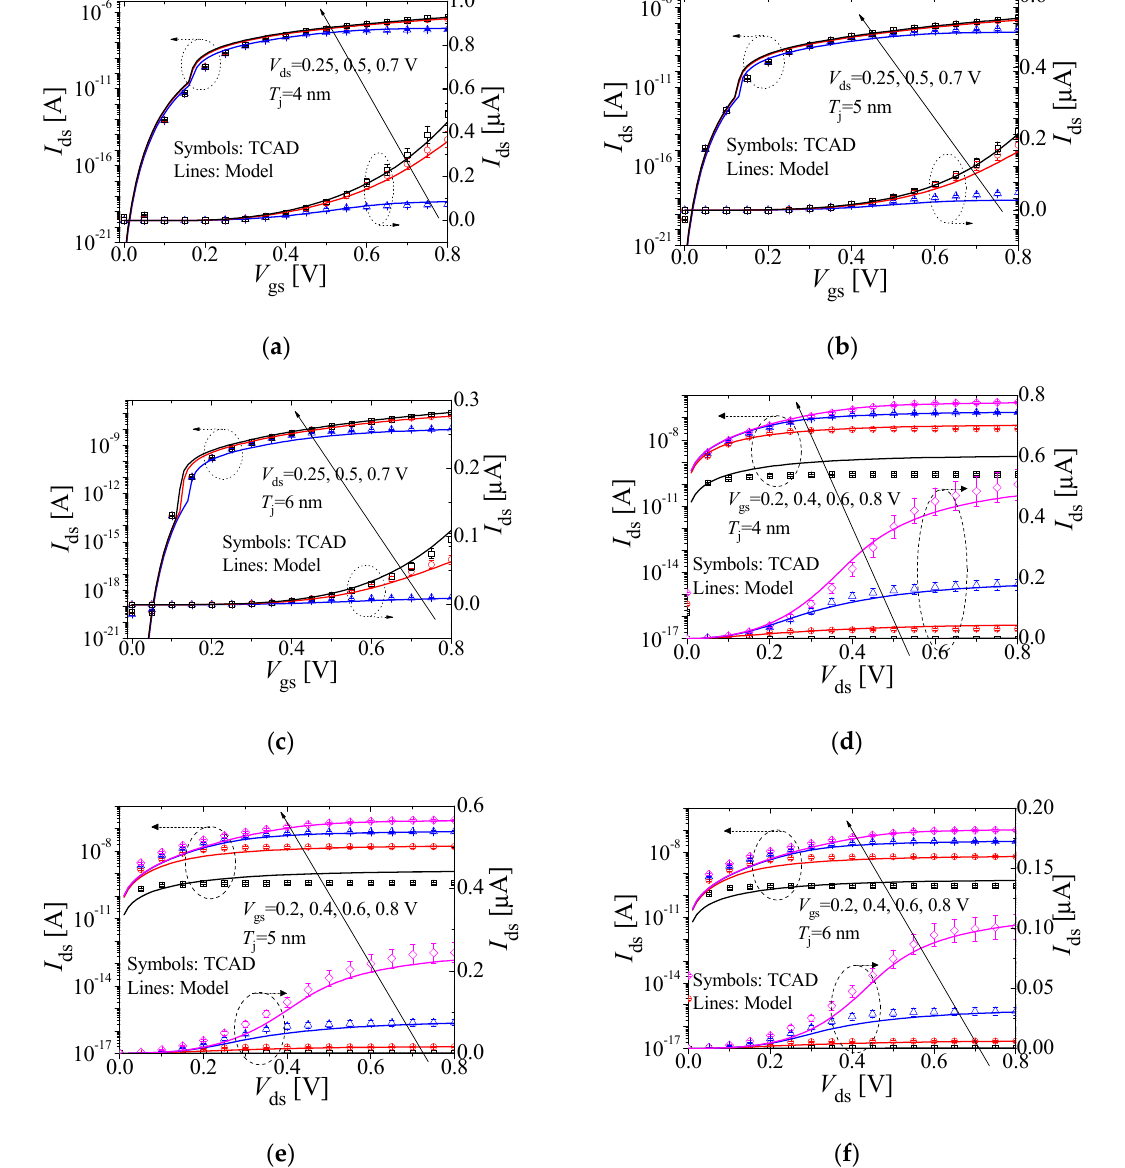
Figure 7. ( a – c ) I ds – V gs characteristics of LTFET with T j = 4, 5, and 6 nm, respectively, at V ds = 0.25 (blue), 0.5 (red), and 0.7 V (black). ( d – f ) I ds – V ds characteristics of LTFET with T j = 4, 5, and 6 nm, respectively, at V gs = 0.2 (black), 0.4 (red), 0.6 (blue), and 0.8 V (magenta). Error bar: 10%. Lines: Model. Symbols: TCAD.